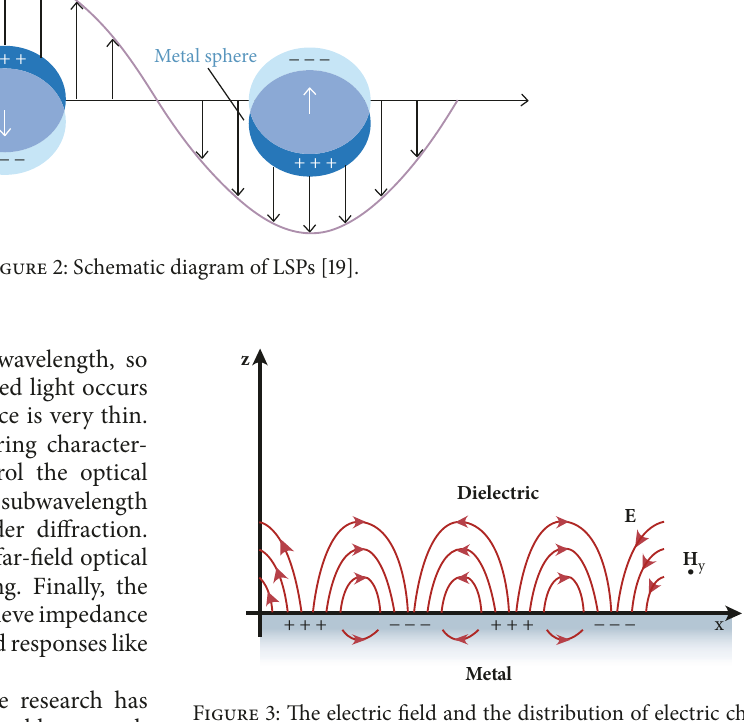
Figure 3: The electric field and the distribution of electric charges during the propagation of the SPPs in metal and dielectric interfaces